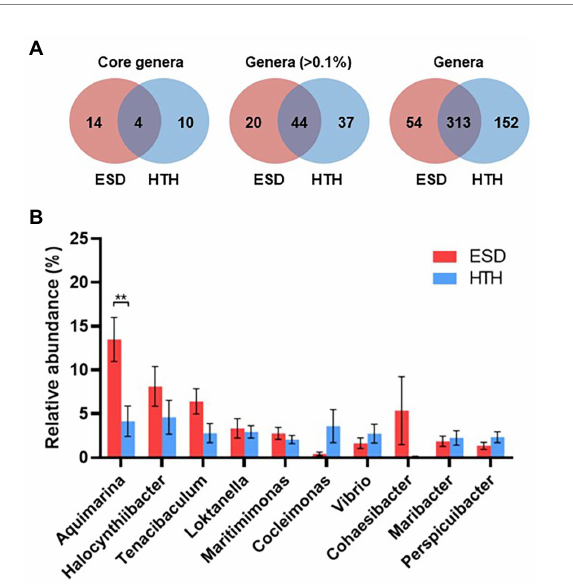
FIGURE 3 Structure of carapace microbiota at the genus level. (A) Venn diagrams showing the number of core bacterial genera shared by all lobsters within each group regardless of their abundance, the number of bacterial genera with >0.1% abundance from any of the samples within groups, and the number of bacterial genera found in any of samples within groups. (B) Relative abundance of the 10 most abundant genera at >1% abundance in all carapace samples. The bars represent the means and their standard errors, and asterisks indicate a statistical significance between groups (Mann–Whitney U test, ** p <